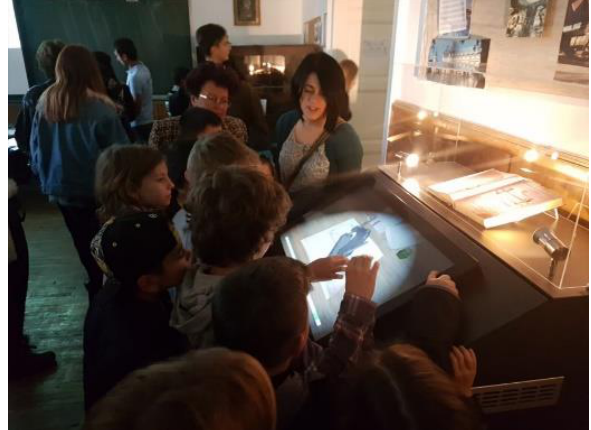
Figure 3. Researchers’ Night participants using the digital book The book was drafted in Vienna in 1768 and ensured the uniform application of Criminal Law in Austria and Bohemia.